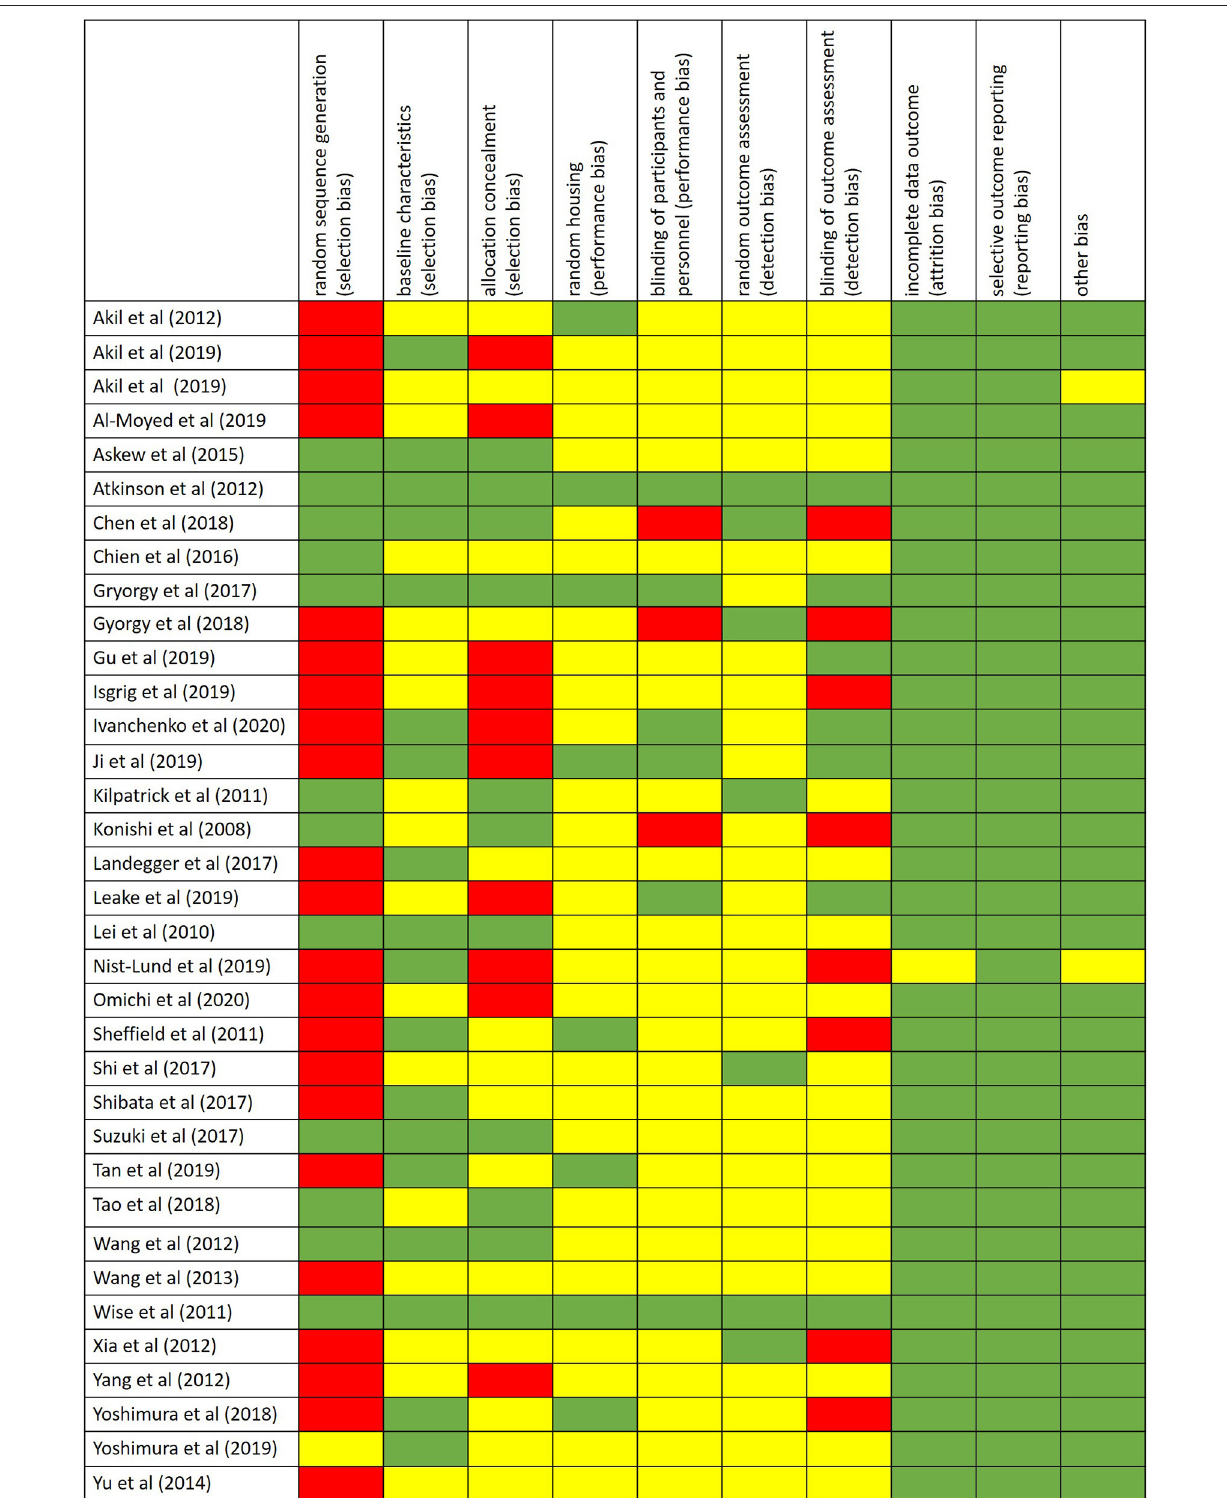
Frontiers in Cellular Neuroscience |